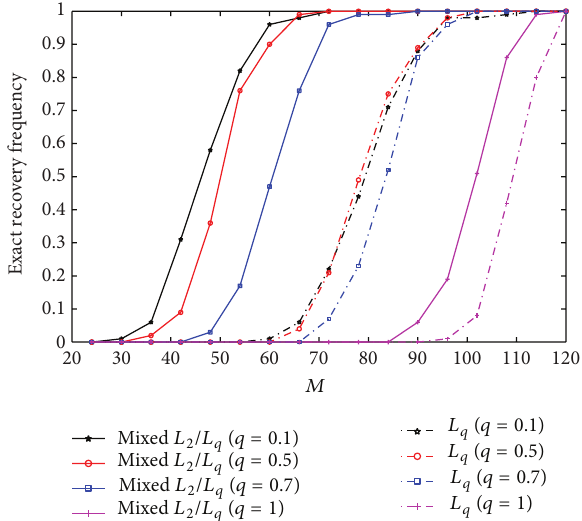
Figure 1: Plots of the exact recovery frequency versus the number of measurements, for the use of the mixed 𝑙 2 /𝑙 𝑞 and the standard 𝑙 𝑞 minimization methods with different values of 𝑞